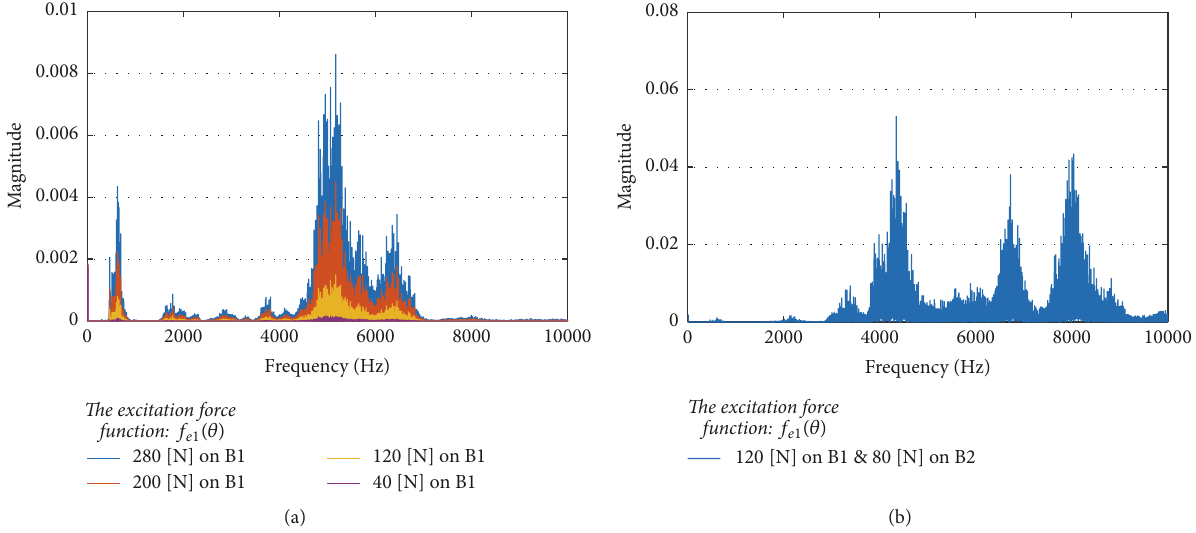
reliabilities of the present vibration-based condition